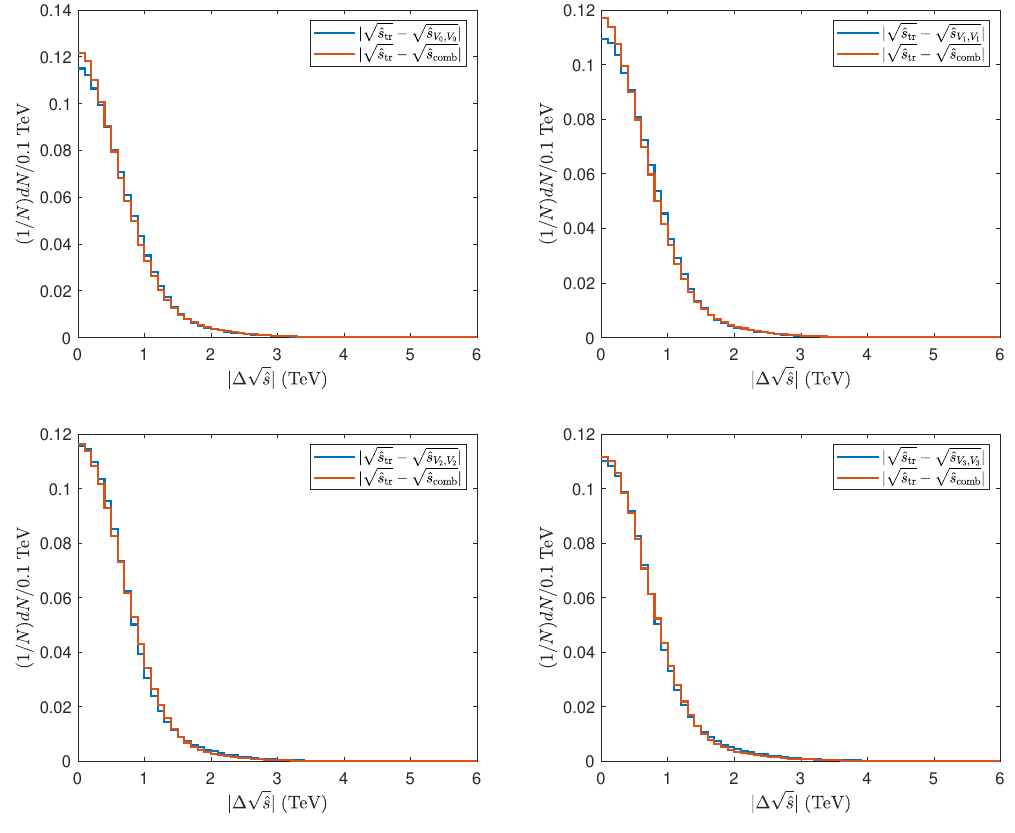
√ s for ˆ s comb compared with those for ˆ s V . i ,V i √ ˆ s for ˆ s and ˆ s are V i ,V i comb